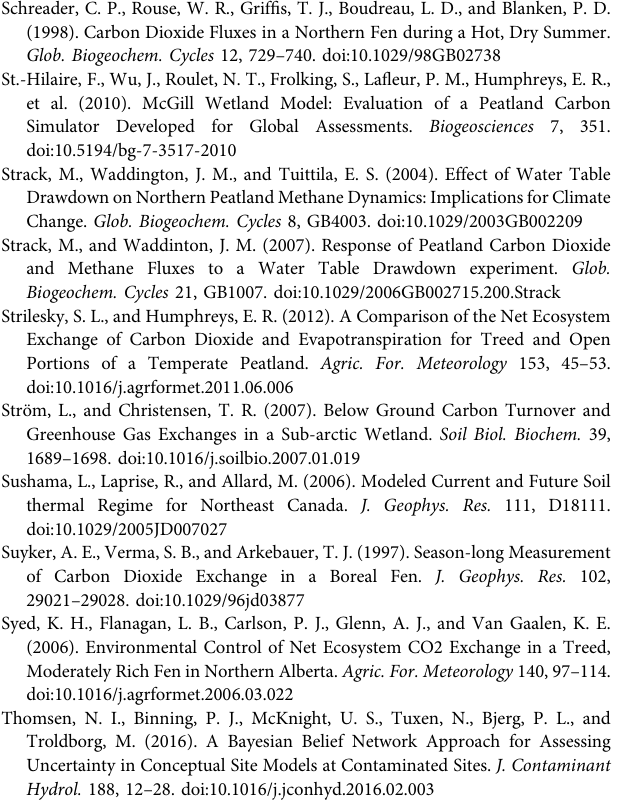
Table Level Threshold Effects on the Net Carbon Dioxide Exchange in a Boreal Fen. Environ. Res. Lett. 9, 05500. doi:10.1088/1748-9326/9/5/055006 Pironkova, Z. (2017). Mapping Palsa and Peat Plateau Changes in the Hudson Bay Lowlands, Canada, Using Historical Aerial Photography and